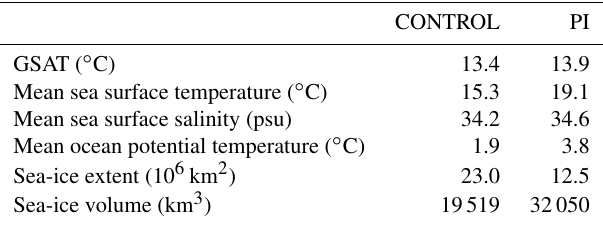
Table 2. Comparison of the Marinoan control climate (CON- TROL, CO 2 = 1500ppmv, CH 4 = 0ppmv, N 2 O = 0ppmv) and the pre-industrial control simulation with present-day continents (PI, CO 2 = 284ppmv, CH 4 = 0.808ppmv, N 2 O = 0.273ppmv). The to- tal solar irradiance is reduced to 95% of its present-day strength in the Marinoan configuration. Both columns represent data averaged over 100